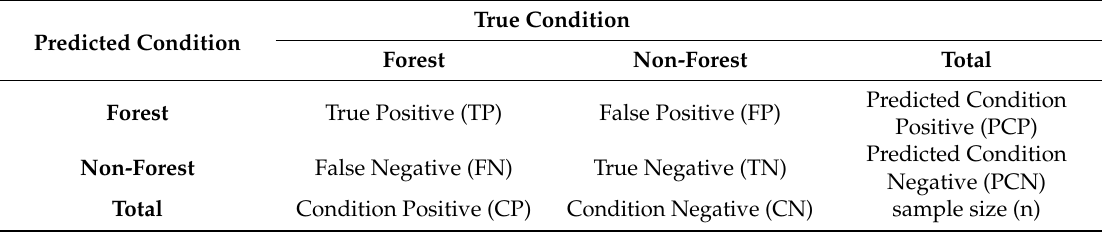
Table 3. Sample confusion matrix for a forest/non-forest classification.